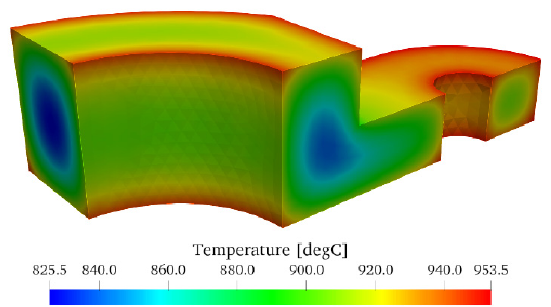
Figure 5. Temperature distribution during the heating phase (geometry scaled 4 times)